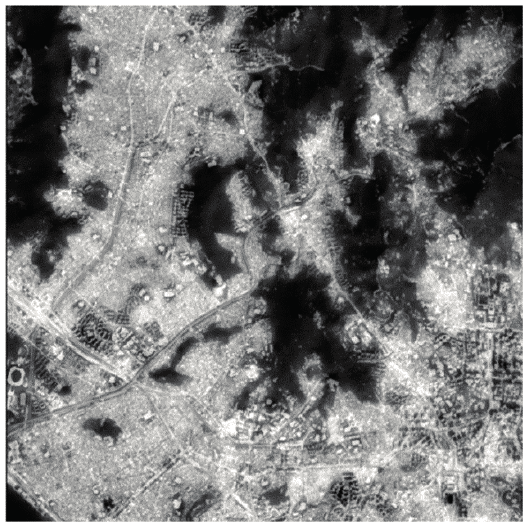
Figure 5. The fused image from the PAN and TIR images of Figure 2a,b using the optimal scaling factor estimated by Equation